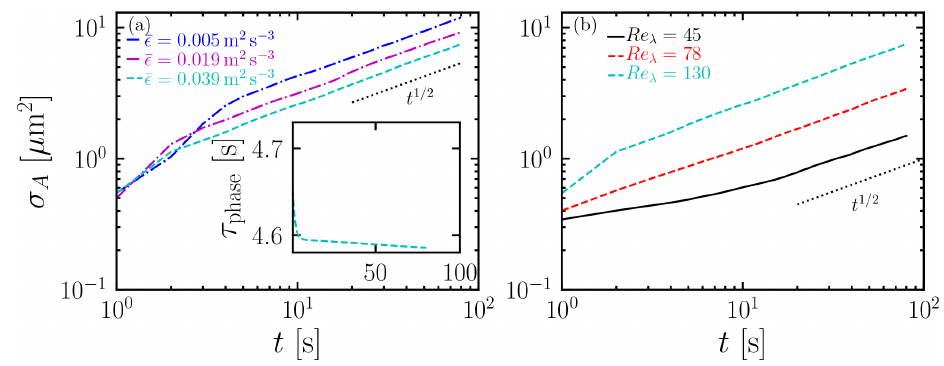
Figure 4. Time evolution of σ A for different (a) (cid:15) at Re λ = 130 and (b) Re λ at (cid:15) = 0 . 039m 2 s − 3 . Same simulations as in Fig. 1.